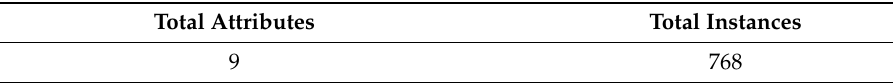
Table 3. Attributes and their feature types.